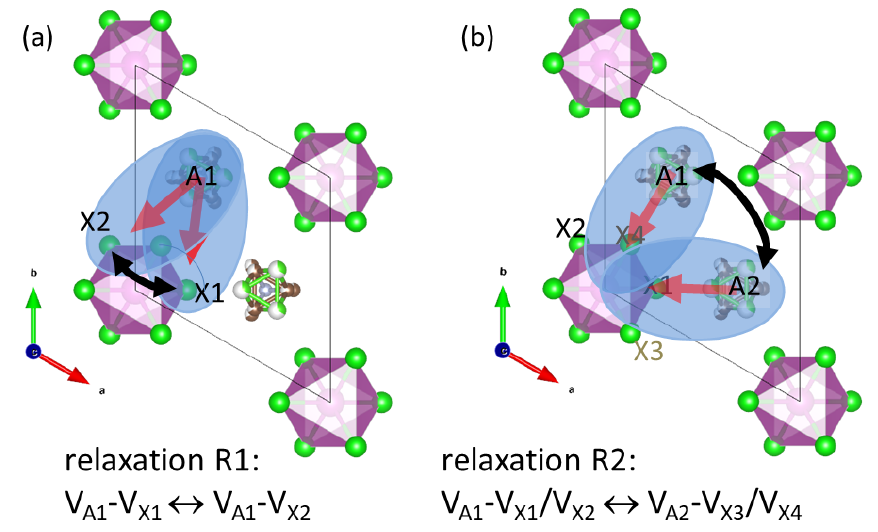
Figure 13. Proposed main contributions to relaxations R1 and